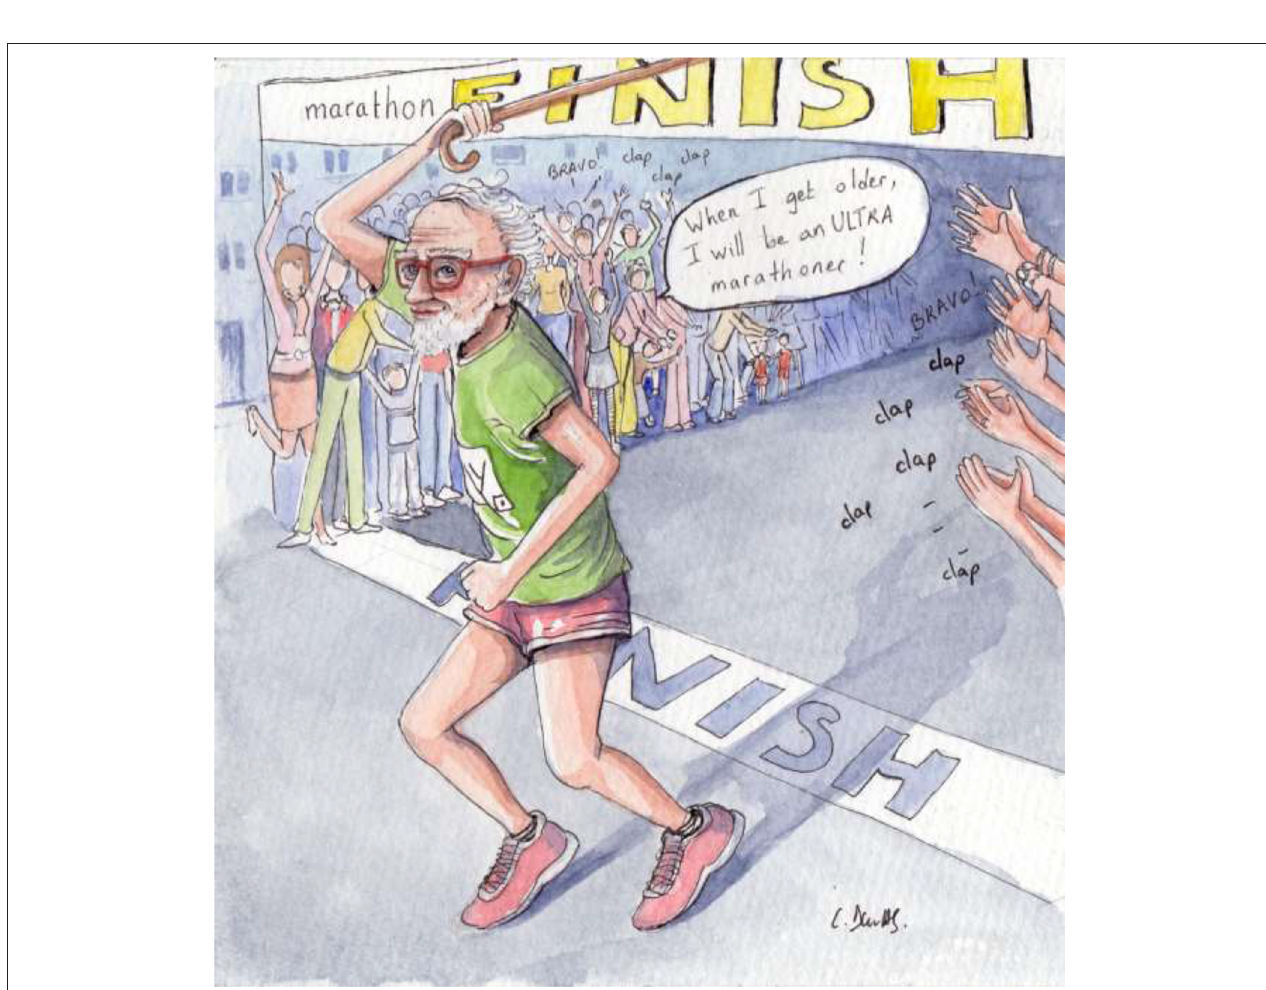
FIGURE 2 | Ultra-marathoners are older than marathoners. Figure by Céline Dewas.